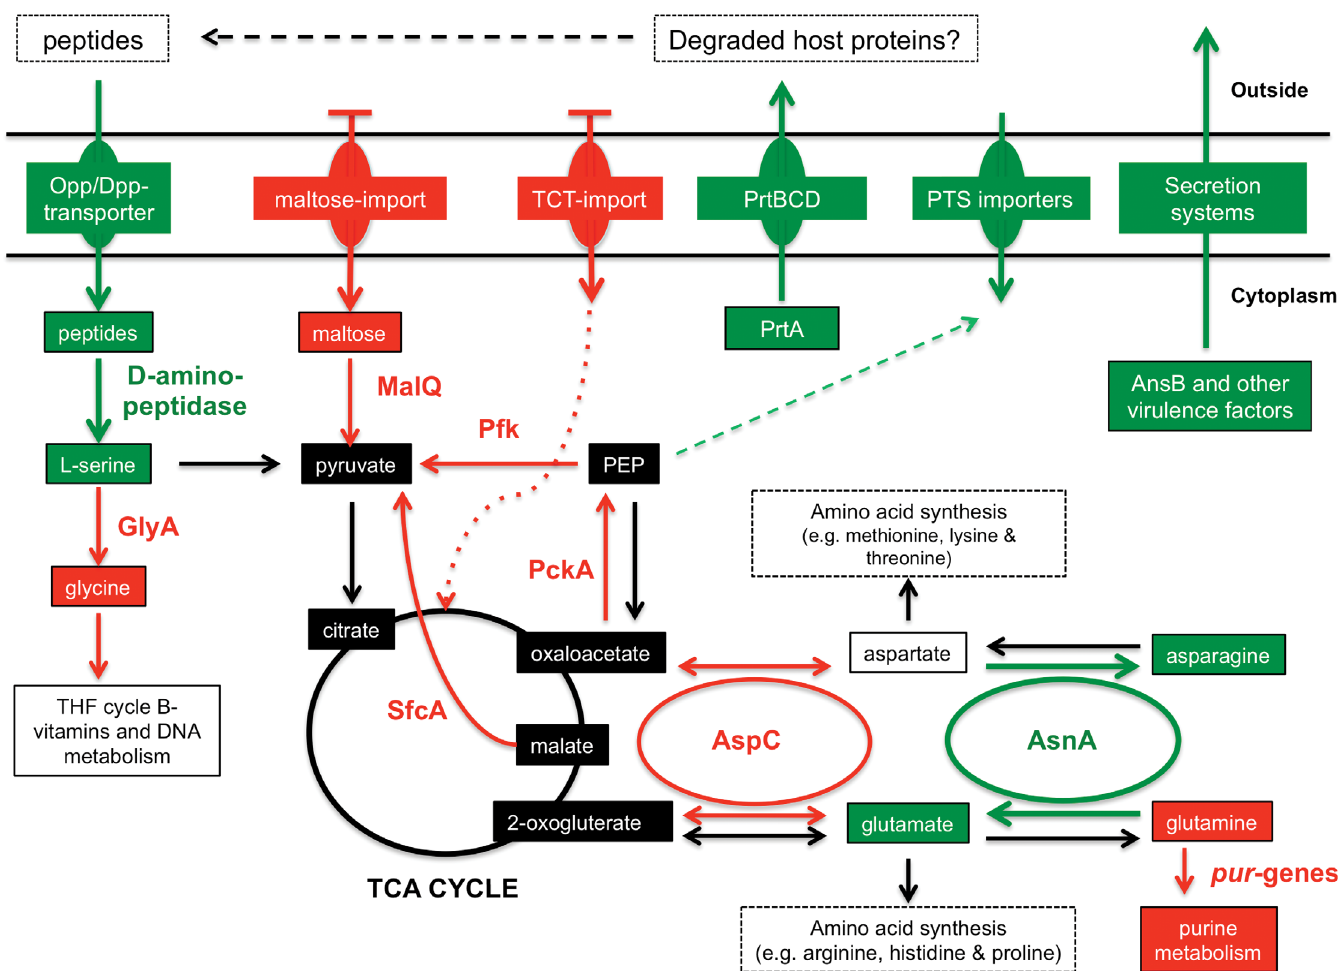
Fig 5. A schematic summarising some key differences in metabolism at 37°C compared to 28°C, centred on glutamate/asparagine metabolism and the TCA cycle. This model is predicted by integrating data from the RNA-seq, proteomics and phenotype microarray studies. Intermediates (boxes) and pathways (arrows) predicted to be down regulated at 37°C are in red while those up regulated are in green. Data suggests TCA cycle intermediates (back boxes) would be relatively isolated from glutamate/asparagine metabolism and could be maintained via the conversion of L-serine into citrate via pyruvate. Black arrows indicate certain potential enzyme pathways that are present and predicted to be unchanged at 37°C. The data suggests a central role for imported peptides and amino acids in metabolism at 37°C. Opp/Dpp represent oligo- and di-peptide importers, TCT represents tricarboxylic acid and PEP is